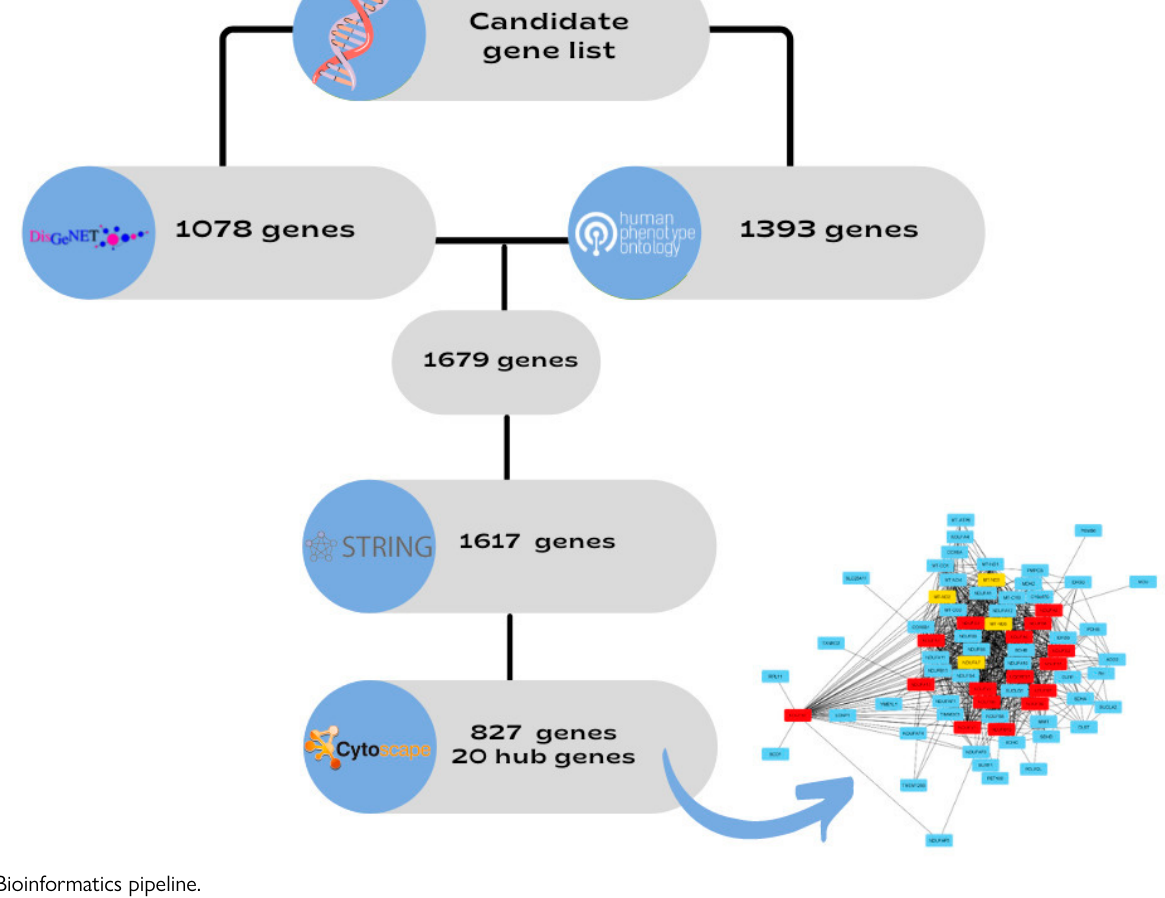
Figure 1. Bioinformatics